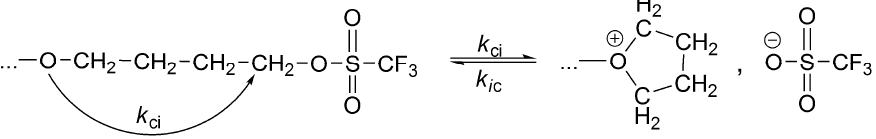
Figure 1. The 300-MHz 1 H-NMR spectra (the 5.0–5.5 τ region only) of living polyTHF with CF 3 SO 2 O − anion: ( a ) in CD 3 NO 2 ; ( b ) in CH 2 Cl 2 ; and ( c ) in CCl 4 solvent (first published in [31], the scale is in τ units).